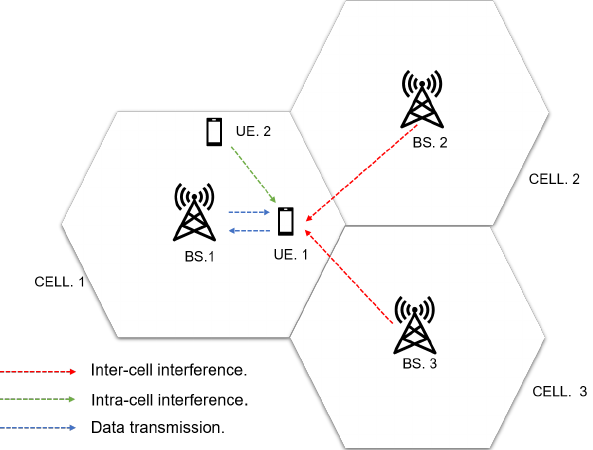
Figure 1. An illustrative example of a cellular network with 3